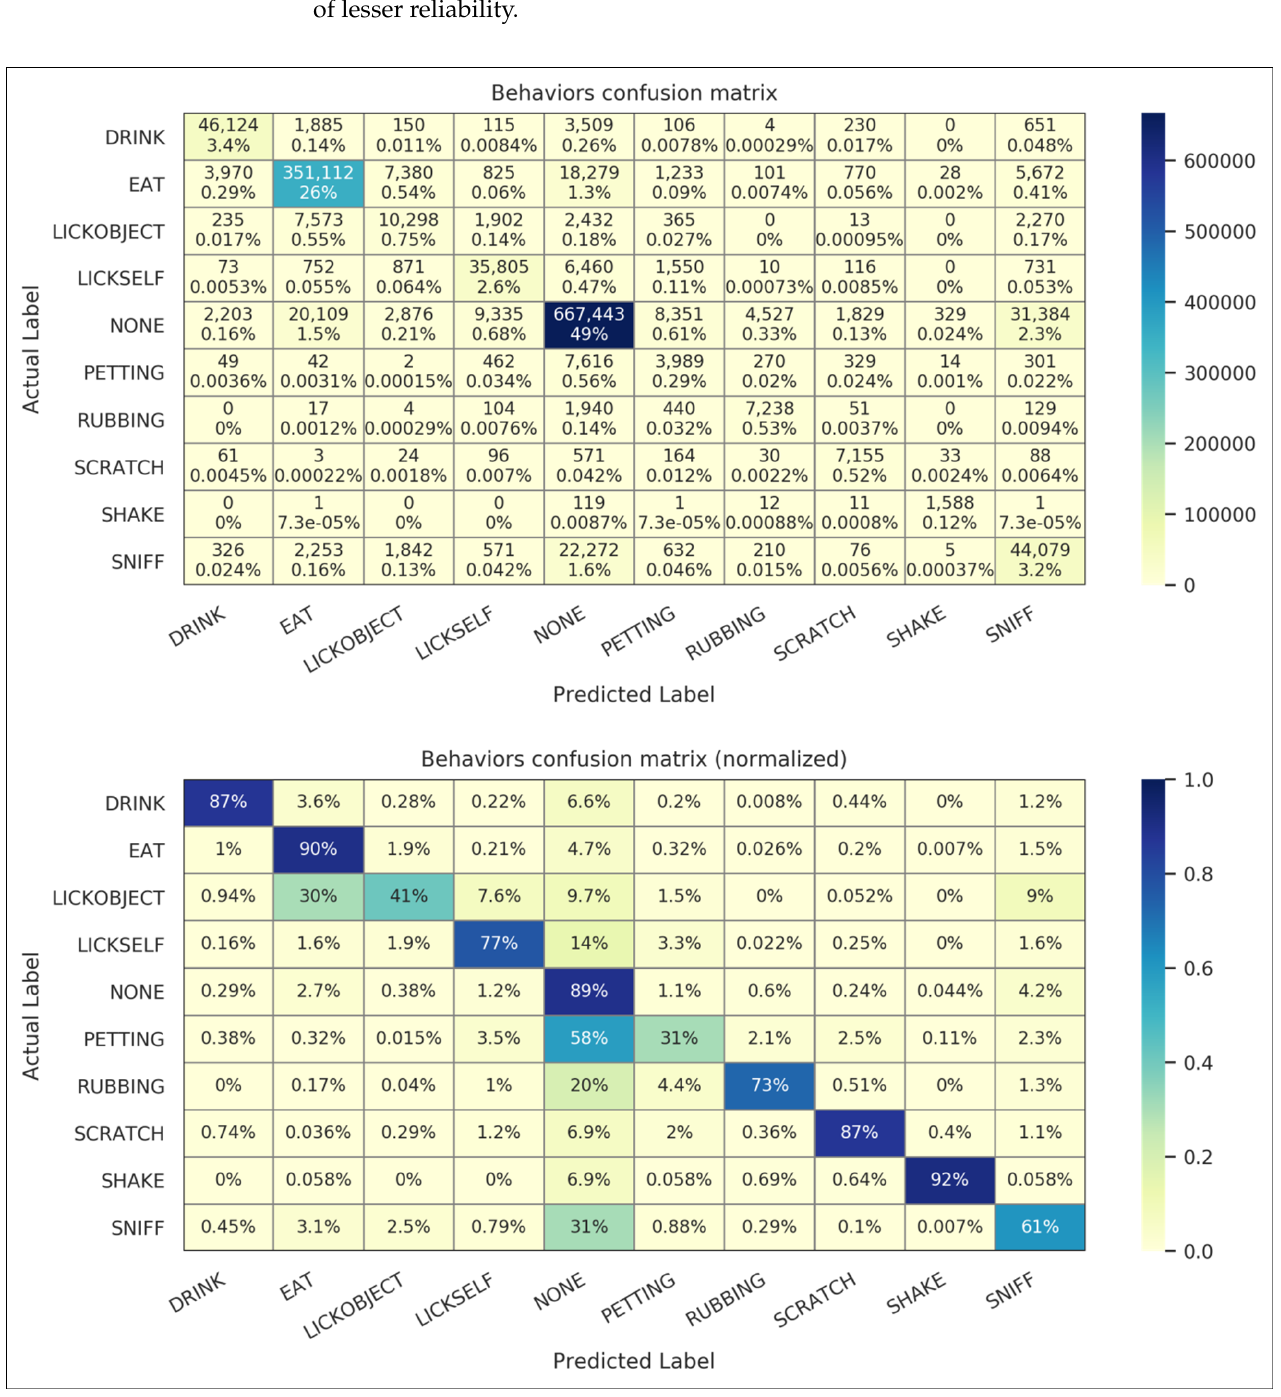
Figure 6. Confusion matrices for crowd dataset behaviors. Time point values in raw counts ( top ) and normalized by time point labels ( bottom ) are shown.